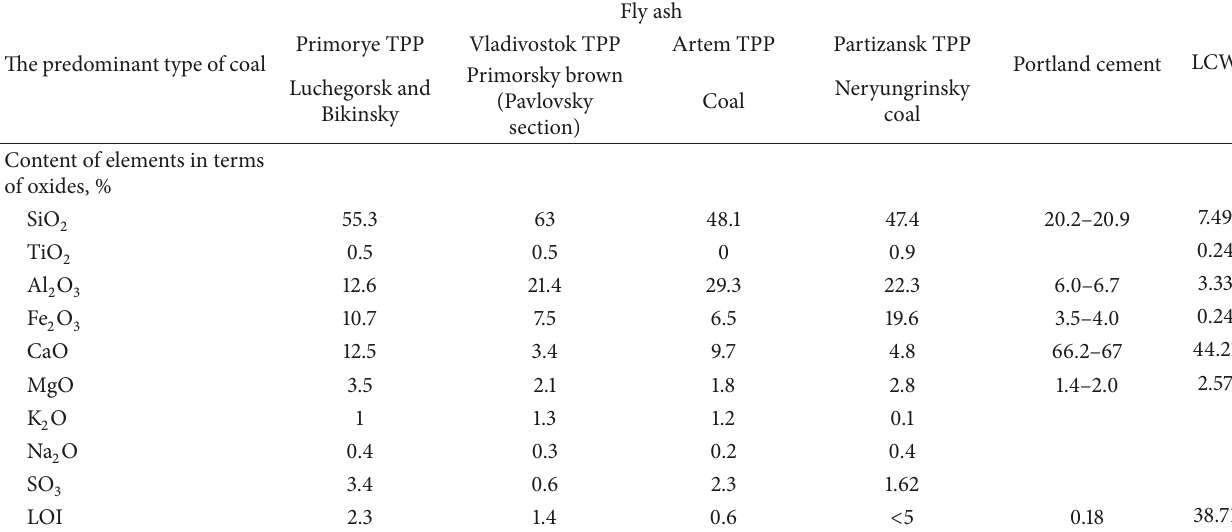
Table 1: The chemical compositions of the fly ashes, Portland cement, and limestone crushing wastes.